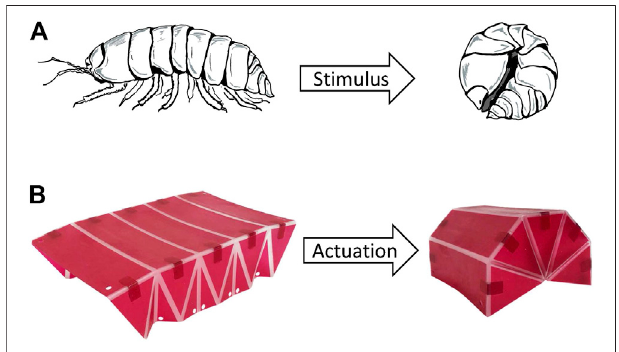
FIGURE 1 | (A) Rolling of a pill bug (Armadillidiidae) in response to external stimulus in a process called conglobation, (B) Rolling of a OPB structure due to cable